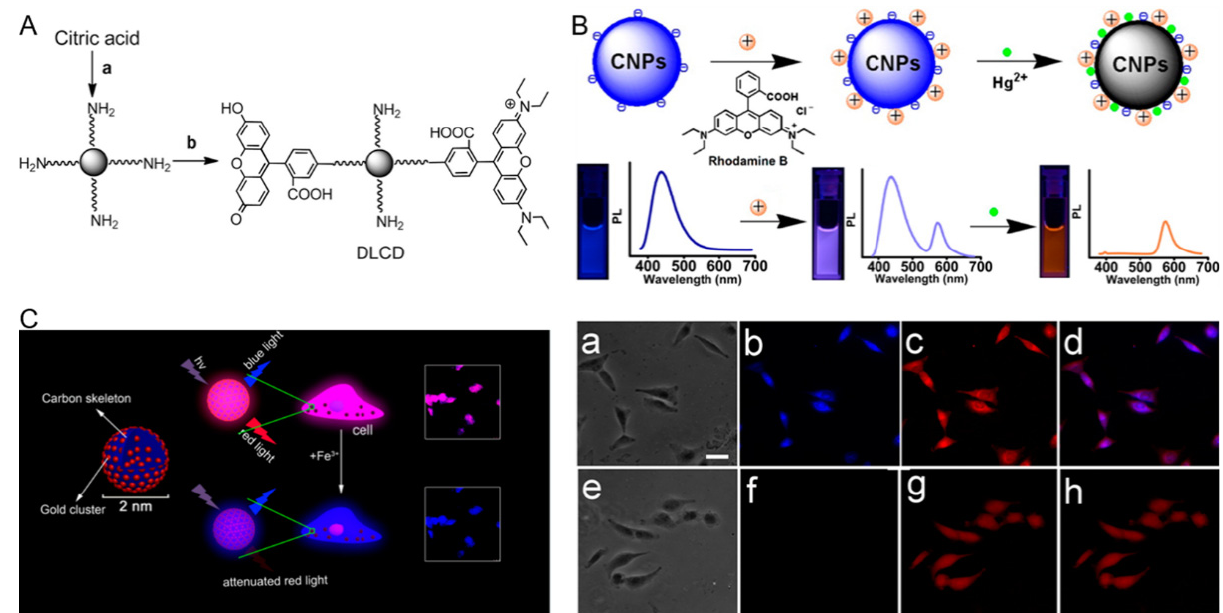
Figure 4. ( A ) Preparation of dual-labeled carbon nanodots (DLCDs). a: TTDDA, 220 °C, 3 h; b: FITC, RBITC, room temperature, overnight. Reproduced from [58], with permission from Wiley, 2012. ( B ) Dual-emission fluorescence sensing of Hg 2+ based on a CNP–RhB nanohybrid system. Images of A549 cells after being incubated with 200 μ L of CNP–RhB nanohybrid solution in the ( a – d ) absence and ( e – h ) presence of Hg 2+ ; ( a , e ) bright-field images; ( b , f ) blue fluorescence field images; ( c , g ) red fluorescence field images; ( d ) the merged images ( b , c ); ( h ) the merged images ( f , g ). The scale bar is 20 μ m. Reproduced from [59], with permission from the American Chemical Society, 2014. ( C ) AuNCs–CD sensor for ratiometric fluorescence imaging of intracellular Fe 3+ . Reproduced from [60], with permission from the American Chemical Society, 2016.